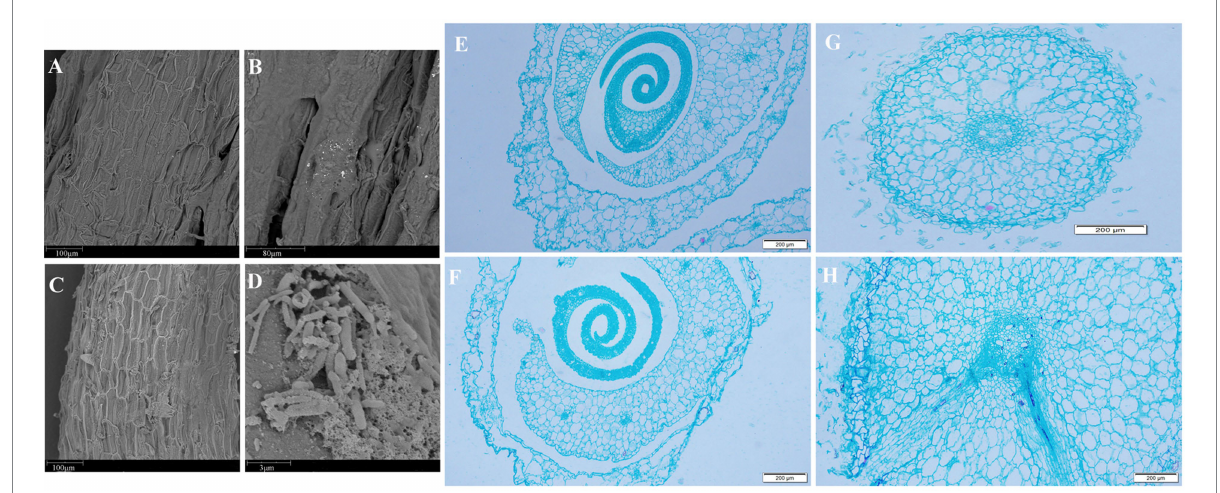
FIGURE 3 The observation of bacterium colonization by scanning electron microscopy (SEM) and paraffin section techniques. (A,B) The root colonization of Curcuma wenyujin without inoculation of WYJ-E13 by SEM. (C,D) The root colonization of Curcuma wenyujin after inoculation of WYJ-E13 by SEM. (E) The bud colonization without inoculation of WYJ-E13. (F) The bud colonization after inoculation of WYJ-E13. (G) The root colonization without inoculation of WYJ-E13. (H) The root colonization after inoculation of WYJ-E13.